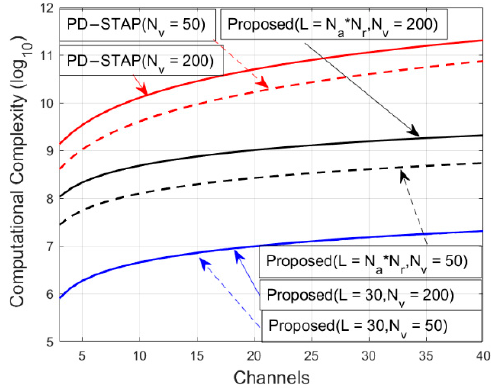
Figure 4. Computational complexity versus channel numbers.